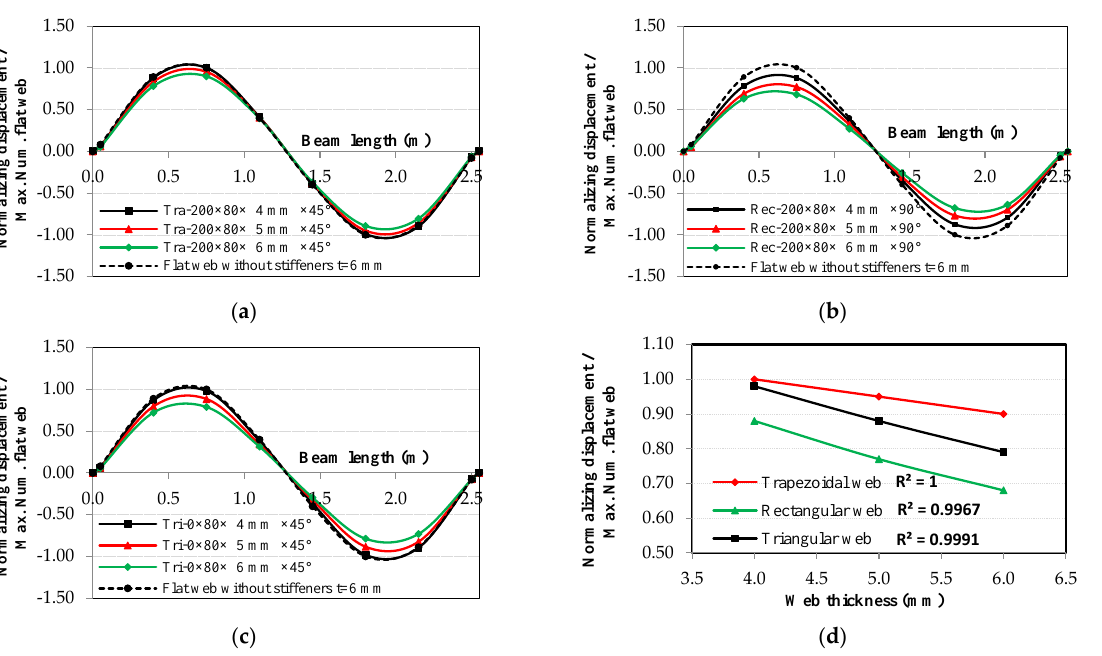
Figure 10. Thickness effect on the relationship between normalized displacement and beam length for the 2nd mode shape: ( a ) trapezoidal web, ( b ) rectangular web, ( c ) triangular web, and ( d ) thickness effect at the 2nd mode